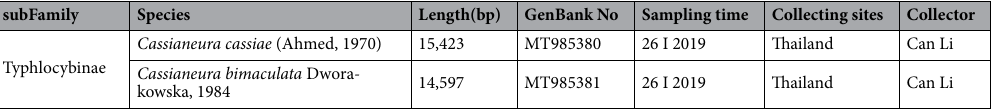
Table 1. Information on samples.